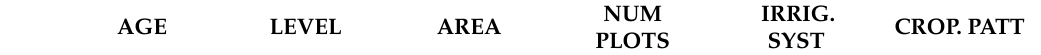
NUM IRRIG. CROP. PLOTS SYST